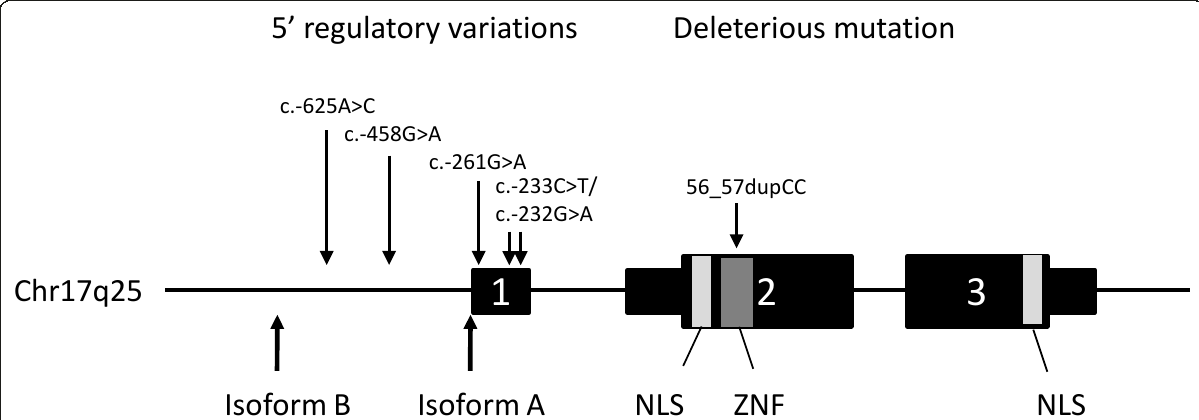
Figure 1 ZNF750 gene structure and variants . ZNF750 consists of 3 exons, with the translation start site within exon 2. Narrow boxes indicate 5 ’ and 3 ’ untranslated regions; wider boxes indicate translated regions. ZNF750 contains two nuclear localization sites (NLS) and a C2H2 zinc finger domain (ZNF). Arrows depict the locations of a deleterious frameshift mutation seen in a Jewish Moroccan family (56_57dupCC), promoter and 5 ’ UTR variations examined in this study (c.-625A>C, c.-458G>A, c.-261G>A, c.-233 C>T, c.-232G>A), and start sites of ZNF750 mRNA isoforms A and